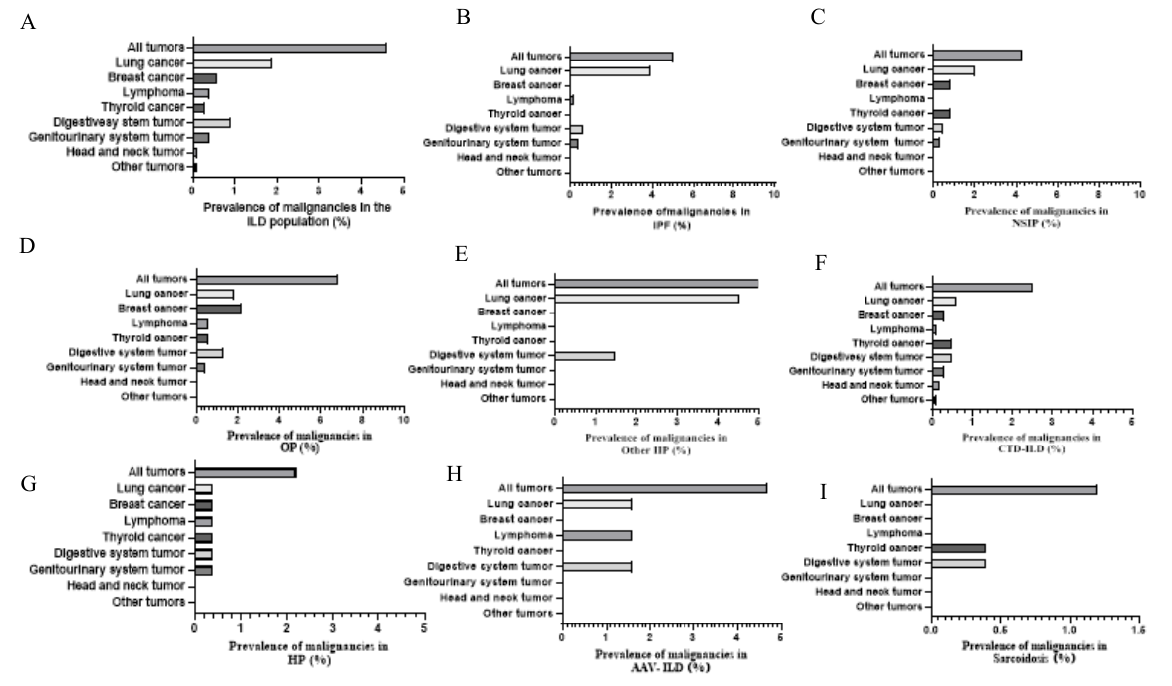
Figure 5. Incidence of malignancies in different ILD subgroups. ( A ) All subtypes of ILD. ( B ) Idiopathic pulmonary fibrosis. ( C ) Nonspecific interstitial pneumonia. ( D ) Organizing pneumonia. ( E ) Other IIP. ( F ) Connective tissue disease-associated ILD. ( G ) Hypersensitivity pneumonitis. ( H ) Anti-neutrophil cytoplasmic antibodies-associated vasculitis related-ILD. ( I ) Sarcoidosis. ILD, interstitial lung disease. The incidence of malignancies in ILD gradually increased from 2.1% in 2015 to 5.9% in Table 5. Malignancies in various subtypes of IIP. 2021. Similarly, the prevalence of lung cancer in ILD increased from 0.4% in 2015 to 2.6% in 2021. The prevalence of other malignancies in ILD did not change significantly over time (Figure